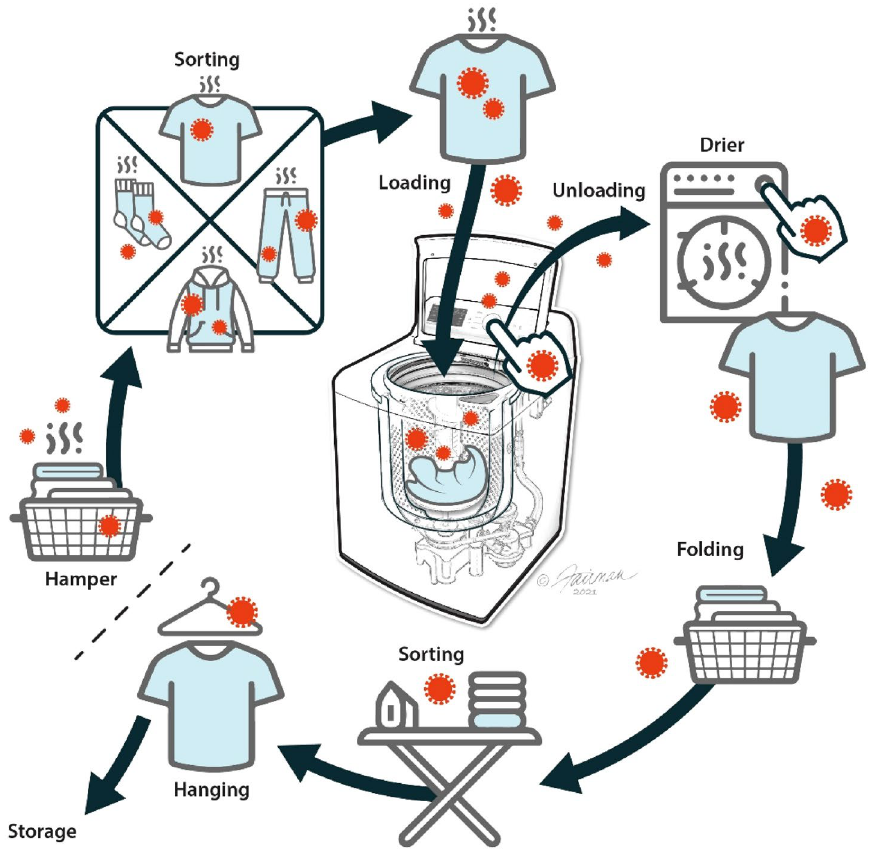
Figure 1. Schematic view of the machine clothes laundering process, indicating possible risk points for enveloped virus accumulation and cross-contamination. These cross-contaminations can potentially be mitigated by application of additional targeted hand/surface hygiene agents 26,33